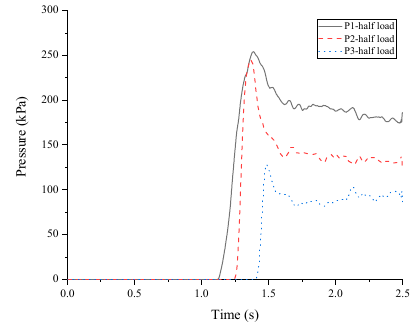
Figure 24. Pressure at P1, P2 and P3 at half load.